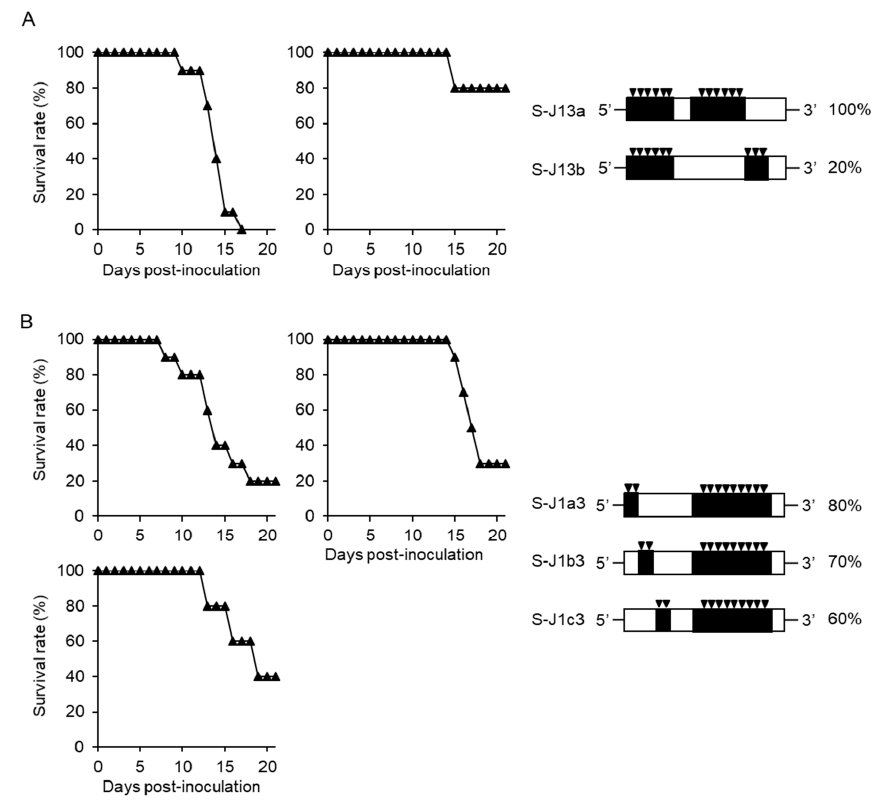
Figure 3. Mortalities of mice infected with S-J13-based recombinant viruses. ( A ) Survival curves and mortality rates of mice infected with 10 4 pfu of S-J13a ( n = 10) and S-J13b ( n = 5) and 3b (NS4B 111 -NS5 567